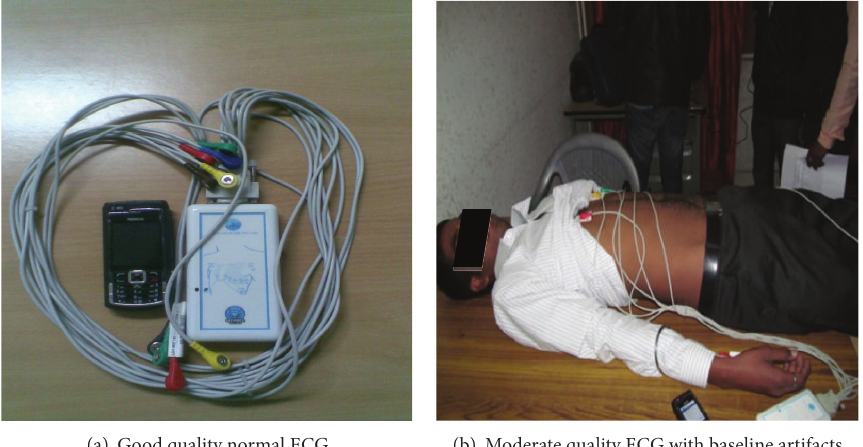
Figure 1: Field testing by ECG.